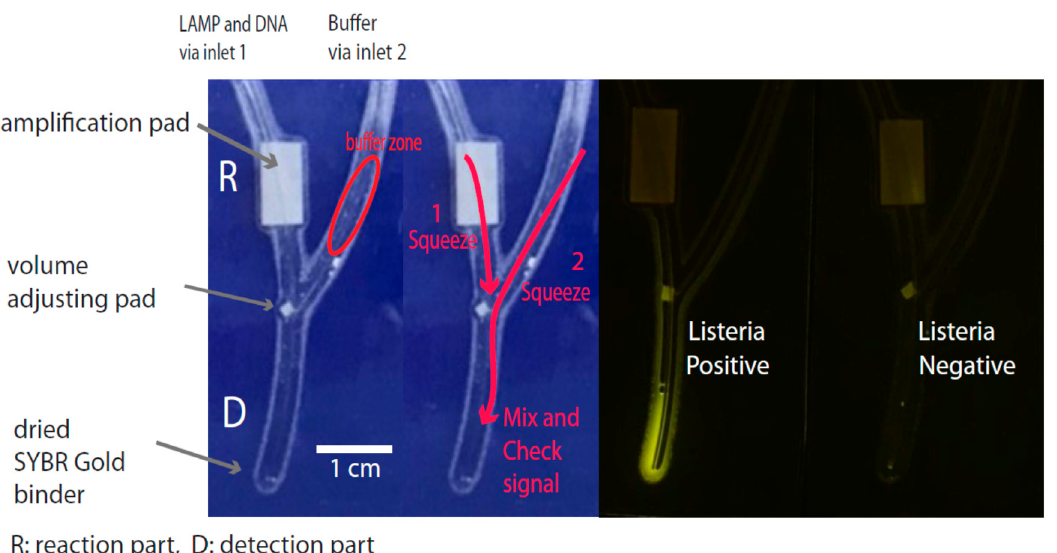
Figure 1. Design of the chip and its structure. The chip was divided into two parts, one for DNA amplification ( R ) and the other for detection ( D ). Both were connected with a channel made of fishing line. The LAMP reagent and DNA sample were introduced via inlet 1, and the blue AgNPLs/probe was introduced via inlet 2. DNA amplification occurred after sealing the inlets with PE stickers and incubating at 63 °C for 30 min. For DNA detection, the amplified products were squeezed to touch a volume adjusting pad first ( arrow 1 ); later, the buffer solution was squeezed through to collect the DNA from the volume adjusting pad ( arrow 2 ), spun down, mixed, and placed on a UV light source. The fluorescence in a positive sample could be visualized by the naked eye.